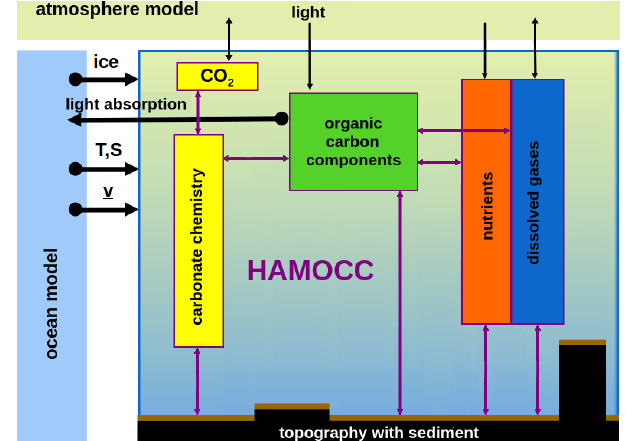
Figure 2. Schematic of the biogeochemical processes simulated by HAMOCC. HAMOCC needs to be coupled to an ocean model that provides the fields of temperature, salinity, and sea-ice cover and transports the HAMOCC tracers according to the flow field. The surface inputs can either come from a coupled atmosphere model or are prescribed. The biogeochemistry in HAMOCC can then feed back to the ocean model via the impact of light absorption on tem- perature and to the atmosphere model via the uptake or release of CO 2